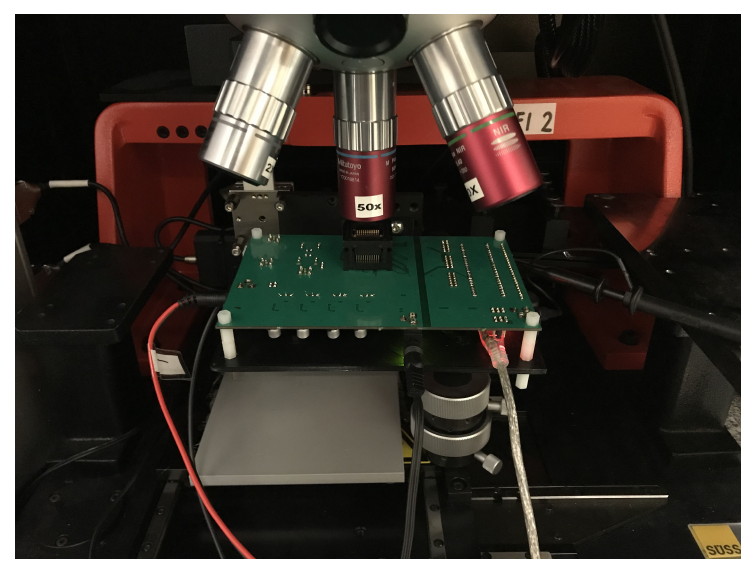
Figure 6: This figure shows the Laser setup used in our experiments. The packaged, opened and polished ASIC is mounted on a custom PCB and the chip surface is targeted with the Nd:YAG Laser to inject